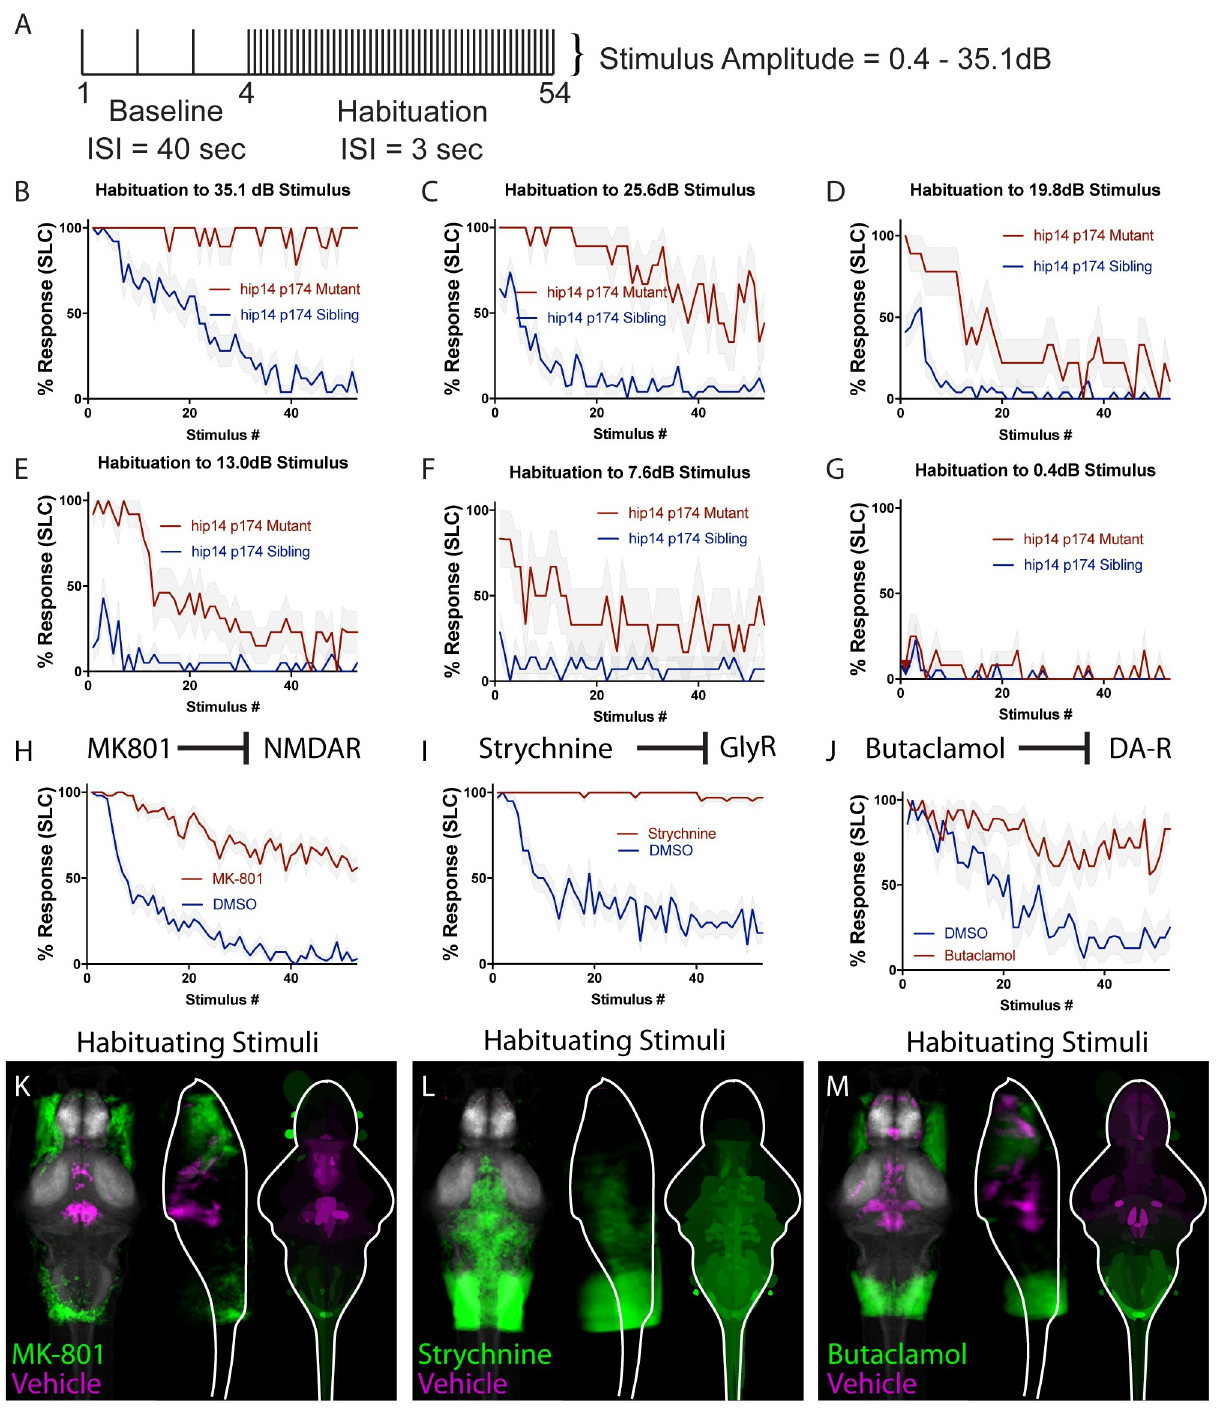
Fig 1. Reduced-intensity habituation assay and unbiased whole-brain imaging to examine impact of pharmacological inhibitors of habituation learning. (A) Stimulus paradigm used. ISI for baseline phase is 40 seconds, ISI for habituation phase is 3 seconds. (B) hip14 mutants exhibit a complete failure to habituate to 35.1 dB acoustic stimuli. (C-G) Reduction in stimulus intensity as indicated results in a gradual increase in the ability of hip14 mutants to habituate. (H) MK-801 is an NMDA inhibitor that strongly reduces habituation learning in 5-day old zebrafish larvae (n = 58 DMSO-treated, n = 57 MK-801-treated, stimulus intensity = 35.1dB). (I) Strychnine is a glycine receptor antagonist that strongly reduces habituation learning in 5-day old zebrafish larvae (n = 38 DMSO-treated, n = 38 Strychnine-treated, stimulus intensity = 35.1dB). (J) Butaclamol is a dopamine inhibitor that strongly reduces habituation learning in 5-day old zebrafish larvae (n = 16 DMSO-treated, n = 18 Butaclamol-treated, stimulus intensity = 35.1 dB). (K-M)